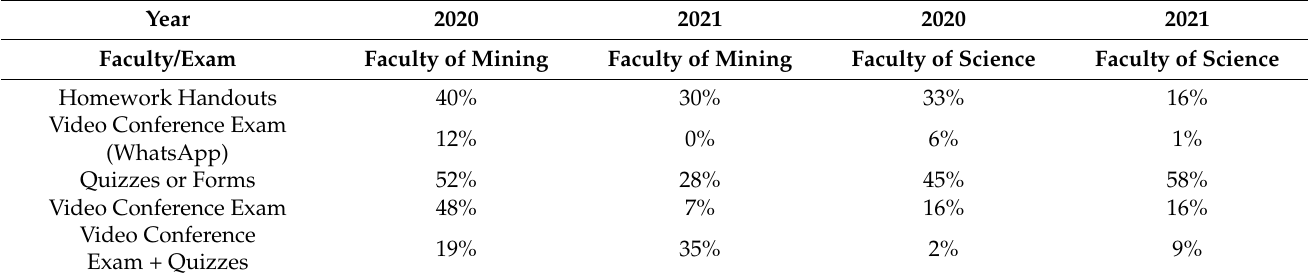
Table 17. Summer exam session 2020 versus winter exam session 2021